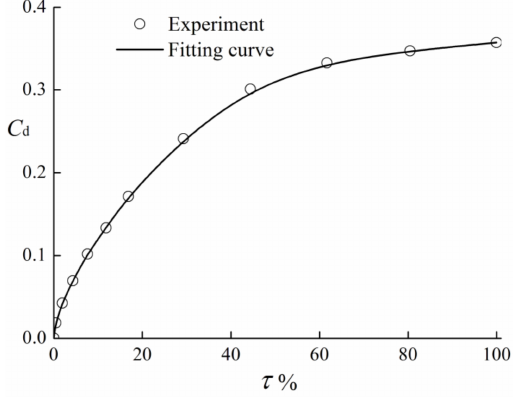
Figure 5. The experimental discharge coefficient of the valve.